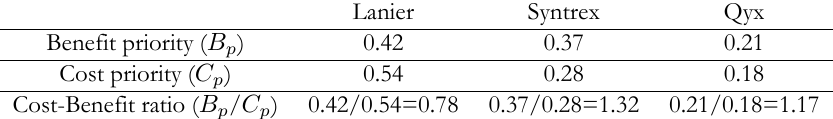
Table 1. Benefit weights, cost weights and cost-benefit ratios in two